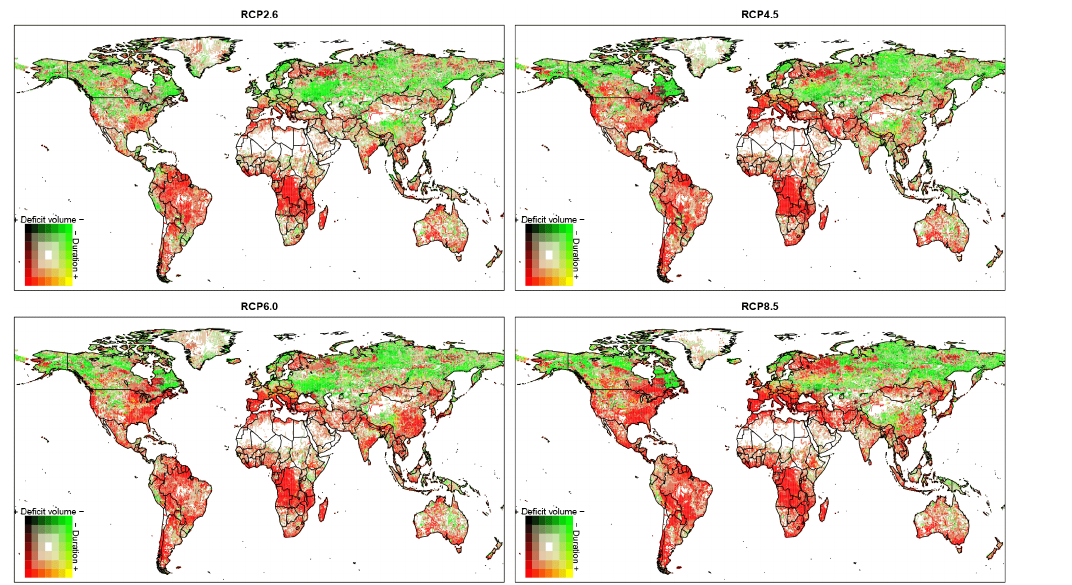
Figure 4. Average trends in drought duration and drought deficit volume, derived with the non-transient Q 90 threshold from discharge simulation of PCR-GLOBWB. Maps indicate the changes per RCP for an ensemble of five GCMs. Colours indicate the robustness of the trend where the darkest colours are robust (five GCMs agree), thereafter likely (four GCMs agree) and plausible (three GCMs agree). A white colour indicates areas where no drought characteristics were